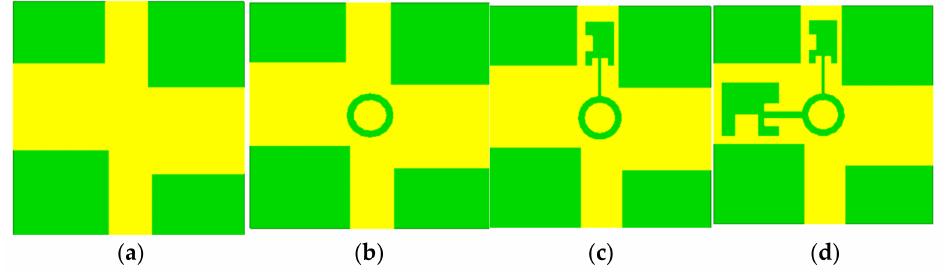
Figure 3. Step-wise design procedure for achieving multiband operation. ( a ) Ant #1, ( b ) Ant #2, ( c ) Ant #3, and ( d ) Ant #4.